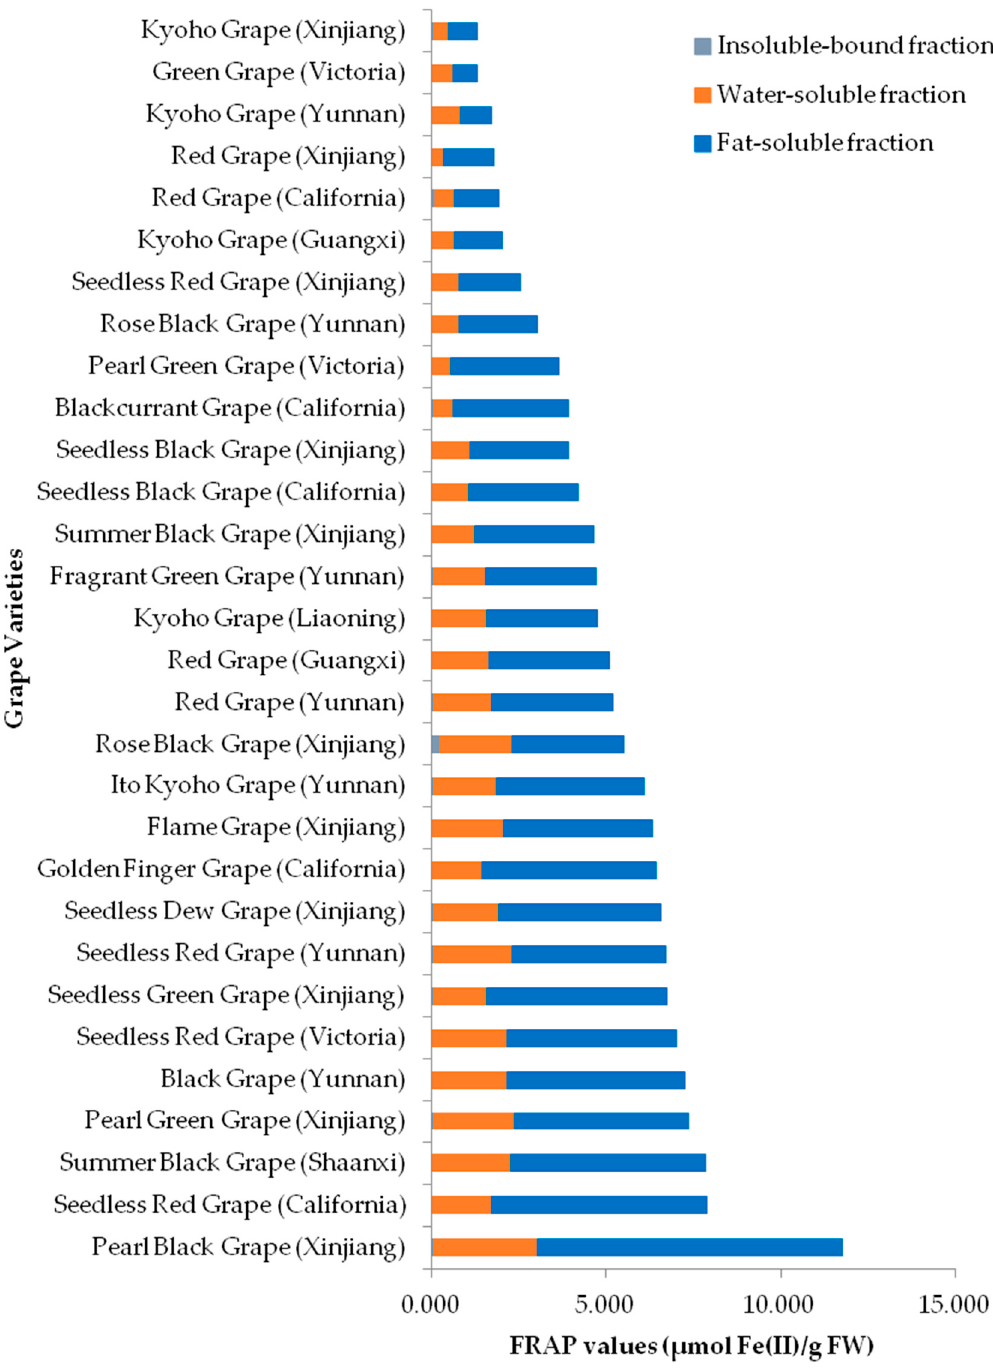
Figure 1. FRAP values of 30 grape pulps.